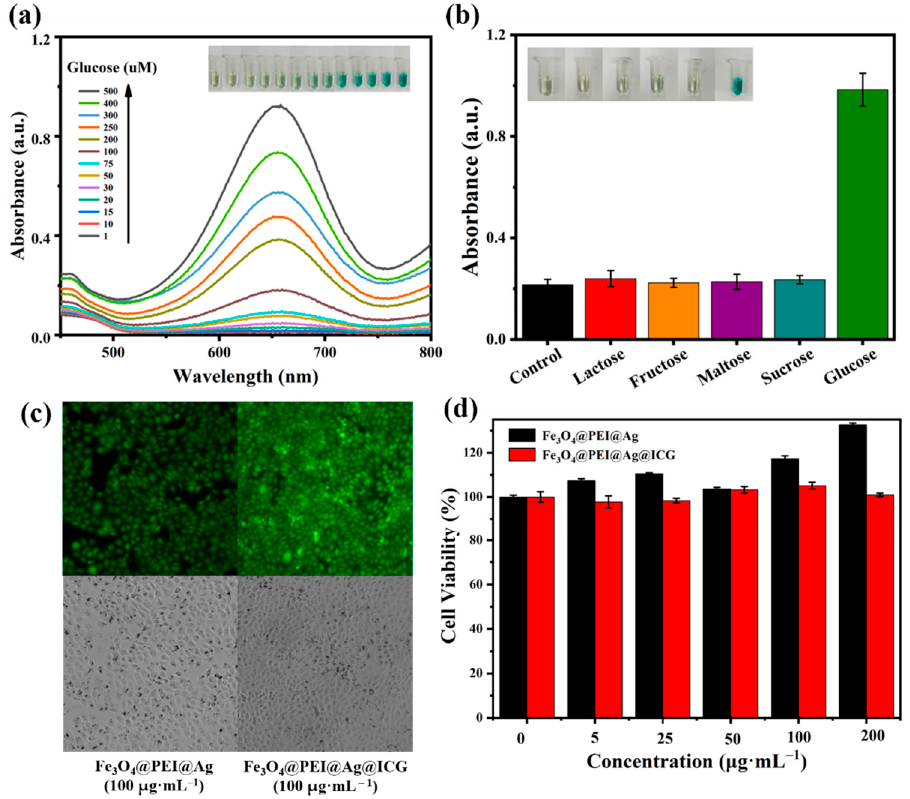
Figure 6. ( a ) UV- vis absorption spectra of the sensing system toward glucose with various concen- trations. The inset image showed the corresponding color changes. ( b ) The selectivity of glucose determination with 5 mM other carbohydrates and 0.5 mM glucose. Insert image shows the color change of different solutions. ( c ) The images of representative fluorescence and optical microscopy with colloidal solution (100 μ g ∙ mL − 1 ). ( d ) The Hacat cell viability of each sample with different colloidal concentrations (5–200 μ g ∙ mL − 1 ) after 24 h.